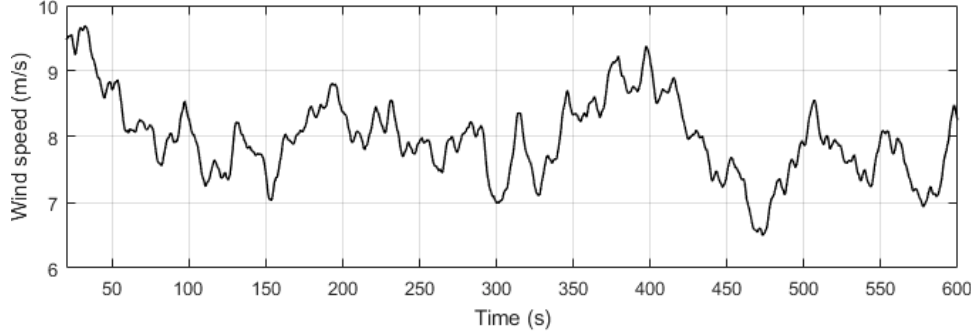
Figure 6. The wind speed.